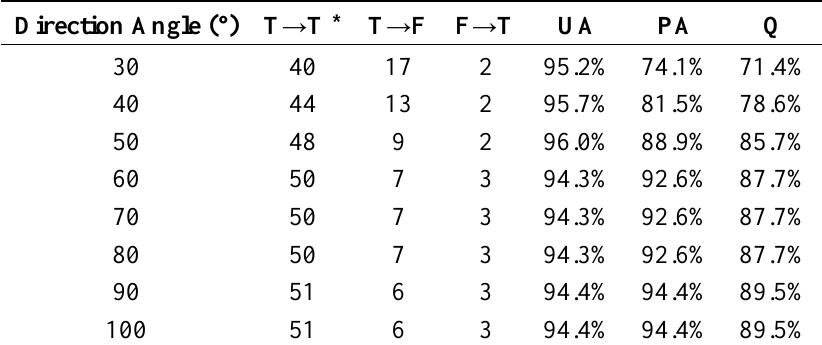
Table 4. The sensitivity of river direction ( Tθ ) in NRBC.